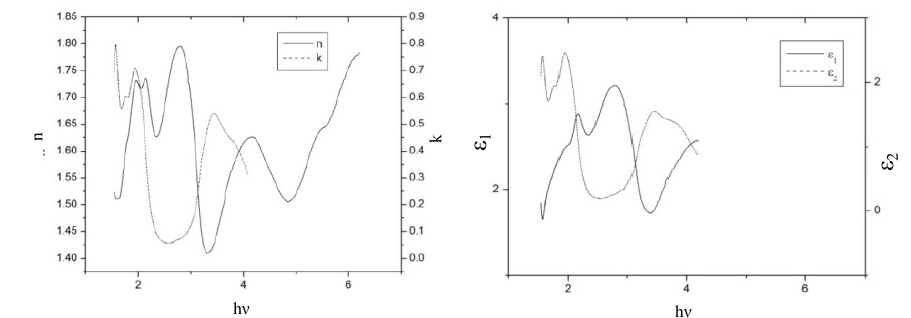
Figure 4. Plot of refractive index n and Figure 5. Plot of real and imaginary parts extinction coefficient k versus photon of the dielectric constant versus photon energy for as deposited F energy for as deposited F CuPc thin film 16